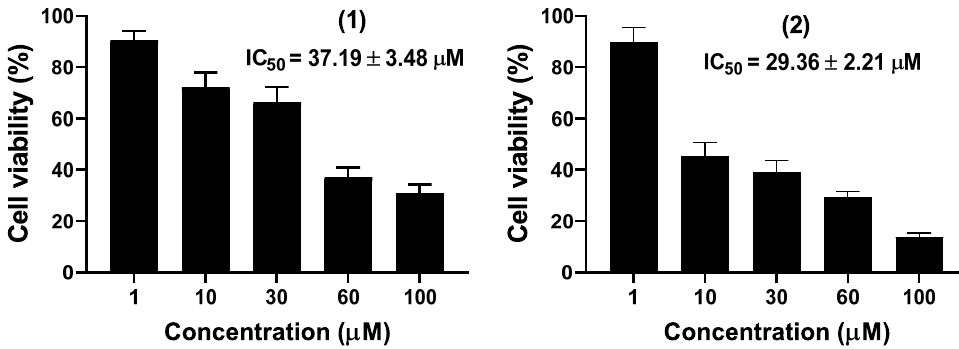
Figure 4. Cytotoxicity of compounds ( 1 ) and ( 2 ) against Raw 264.7 cancer cell line.